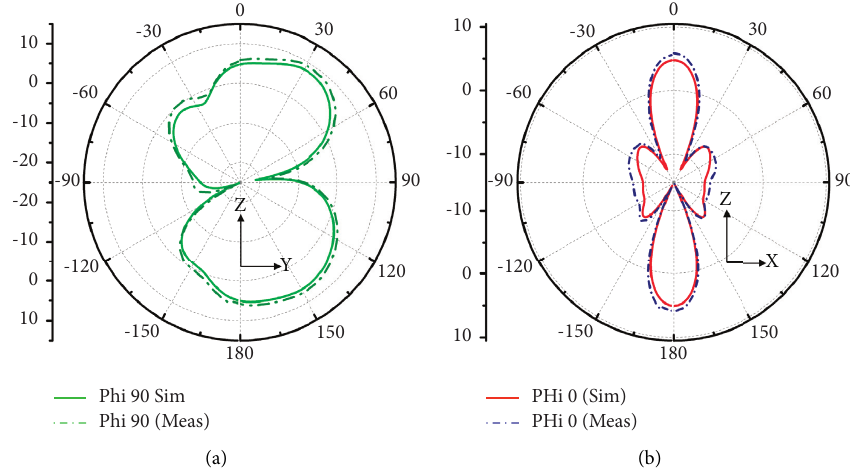
Figure 10: Radiation pattern of proposed array at 28GHz: (a) Phi � 90; (b) Phi � 0.